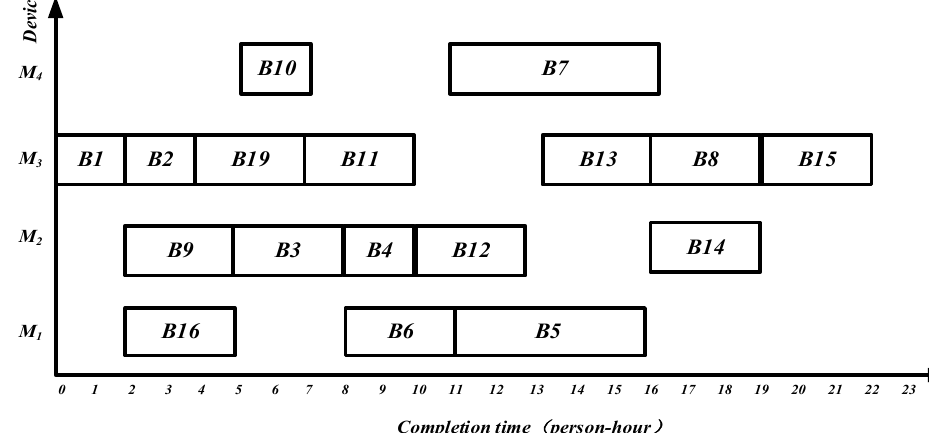
Figure 23. Gantt chart by the TS for workshop f 1 with 22